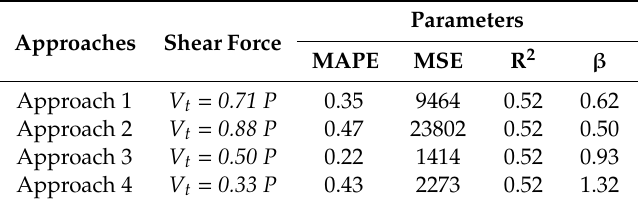
Statistical error indicators for the di ff erent approaches applied to the strengthened walls—procedure